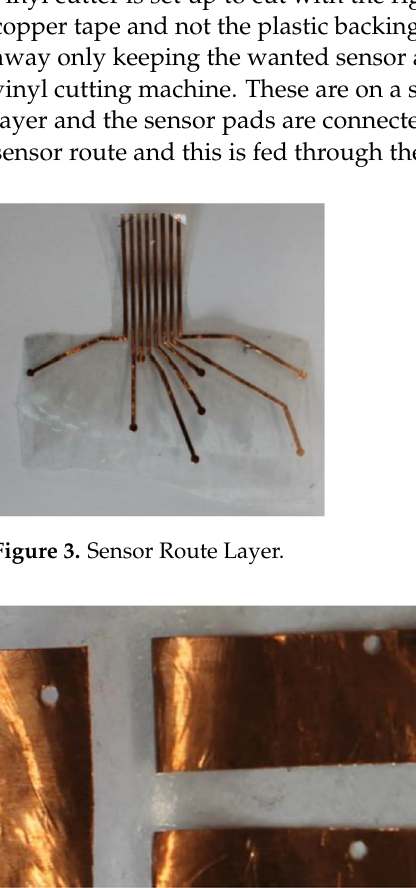
Figure 5. Route layer with conductive tape. Figure 6. Assembled sensor installed on the outsole. 2.3. Sensor Layer Layout The sensor layer layout consists of the manufactured sensor pads and route layer using the vinyl cutting machine as pictured in Figures 7 and 8.